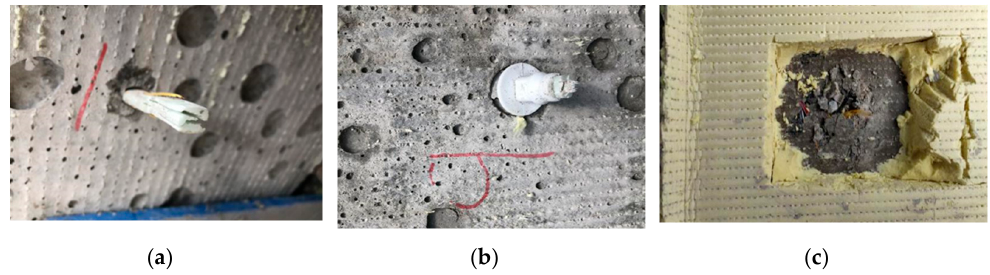
Figure 11. Failure mode of Q2 wallboard connector (part). ( a ) Fiber layer splitting damage; ( b ) fracture at the anchorage of connector; ( c ) concrete damage at anchorage.